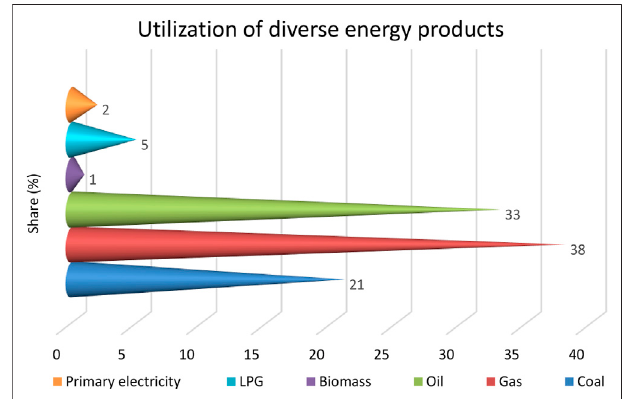
FIGURE 3 | Malaysia ’ s utilization of diverse energy products in